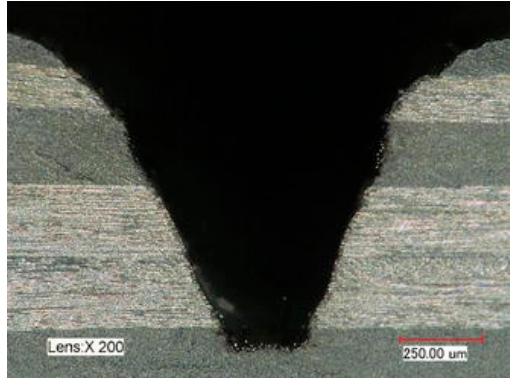
rate, and scanning speed as significant parameters. The ANOVA for MRR indicates that repetition rate and laser fluence are the parameters with influence. Moreover, there are significant interactions for all of them.